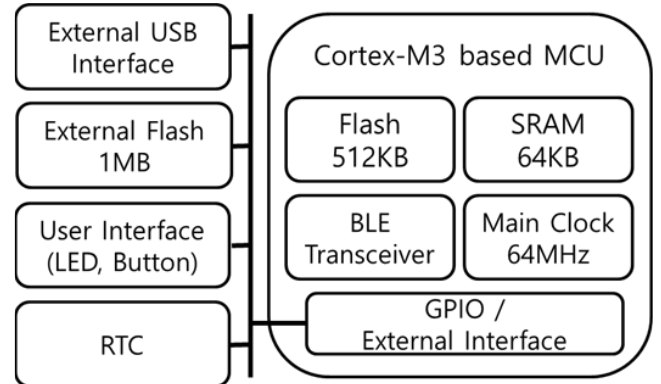
Figure 2. Hardware Block Diagram of Location Anchor Node.